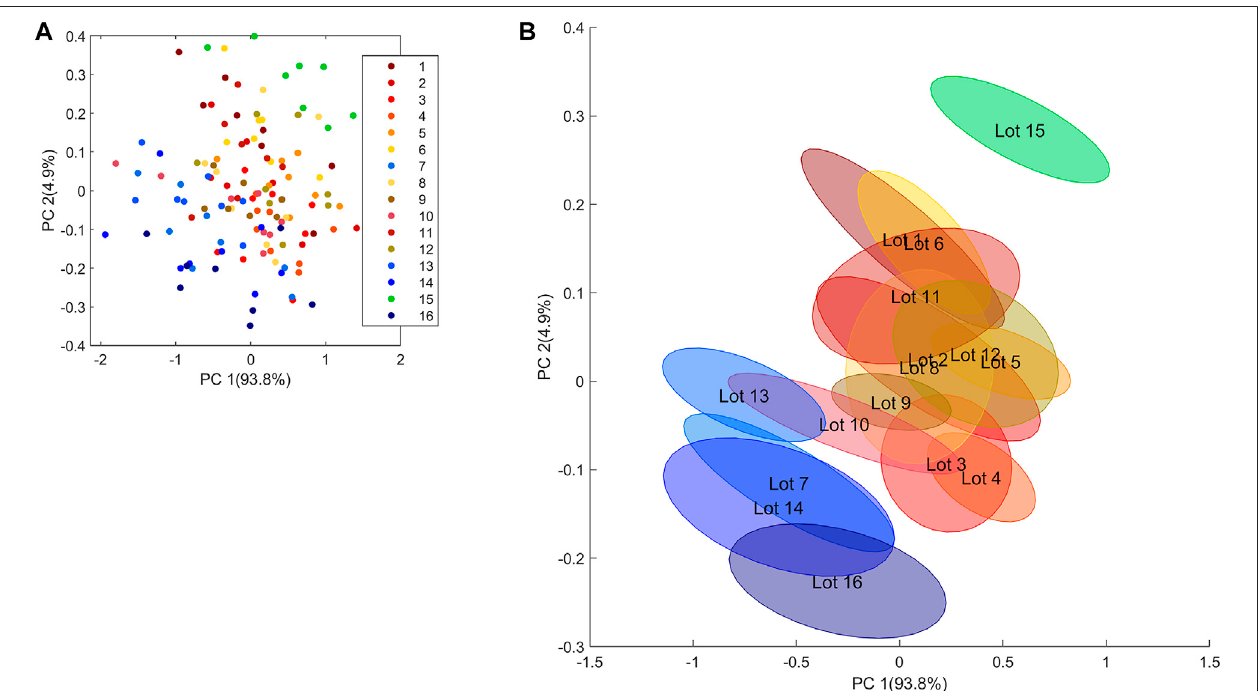
FIGURE 6 | PCA on the average spectra at the subsample level. Each lot has been colored in shades of blue, red, and green. The color scheme is based on the positionofthelotsinthescorespace. (A) The fi rsttwoscorescoloredaccordingtothelotnumberand (B) PCAscoreplotofthewastewoodsamplewithstandarderror ellipses for each lot.